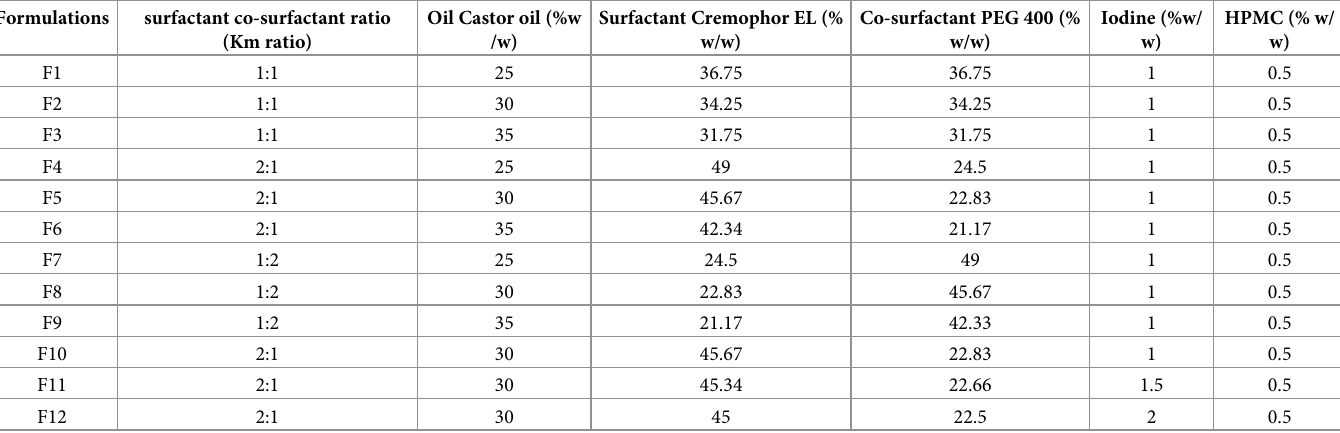
Table 1. SNEDDS formulations comprises of different concentration of oils, surfactant and co-surfactants. Formulations surfactant co-surfactant ratio (Km